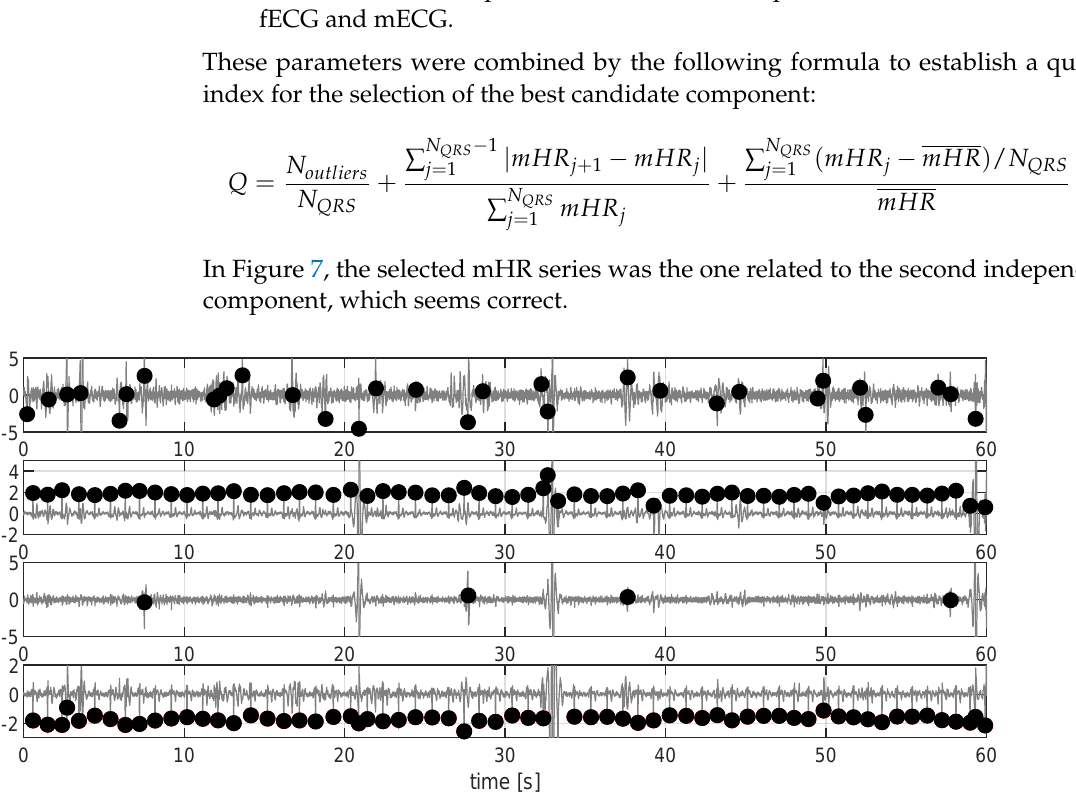
Figure 7. The main independent components obtained after the first ICA and the mQRS (black dots) detected for each